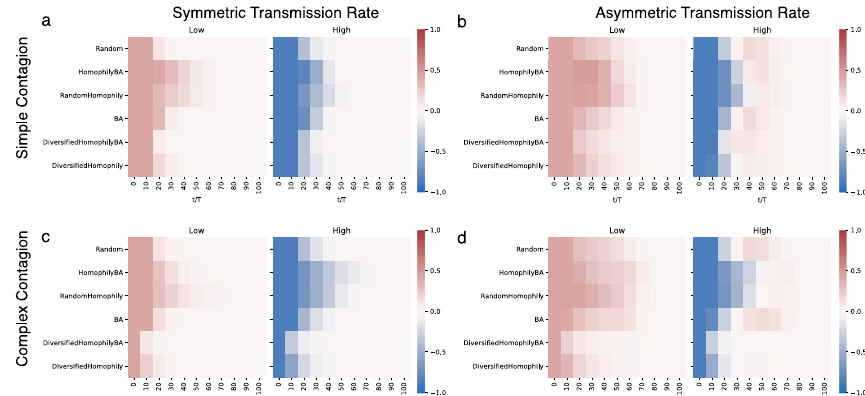
Fig. 2 Information spreading equality of different network models. We plot the spreading equality with low and high minority seeding portions. Each plot is a heatmap, where the x‑axis represents the relative time t / T , the y‑axis represents the different models, and the color represents � I ( t / T ) . Recall that � I ( t / T ) = 0 represents equality. When the minority seeding portion is low, � I ( t / T ) is initially positive (i.e., the majority group has a greater advantage); it then decreases to 0 for all models. When the minority seeding portion is high, � I ( t / T ) is initially negative (i.e., the minority group has a greater advantage). Under symmetric transmission, � I ( t / T ) increases to 0. However under asymmetric transmission, � I ( t / T ) increases to 0, then becomes positive, and eventually becomes 0. We observe that regardless of the contagion type and the seeding condition, Homophily BA and Random Homophily take longer to reach � I ( t / T ) = 0 , indicating less equality. On the contrary, Diversified Homophily BA and Diversified Homophily reach � I ( t / T ) = 0 faster, sometimes even faster than Random Network and BA, indicating more equality. The differences between the models are more pronounced under complex